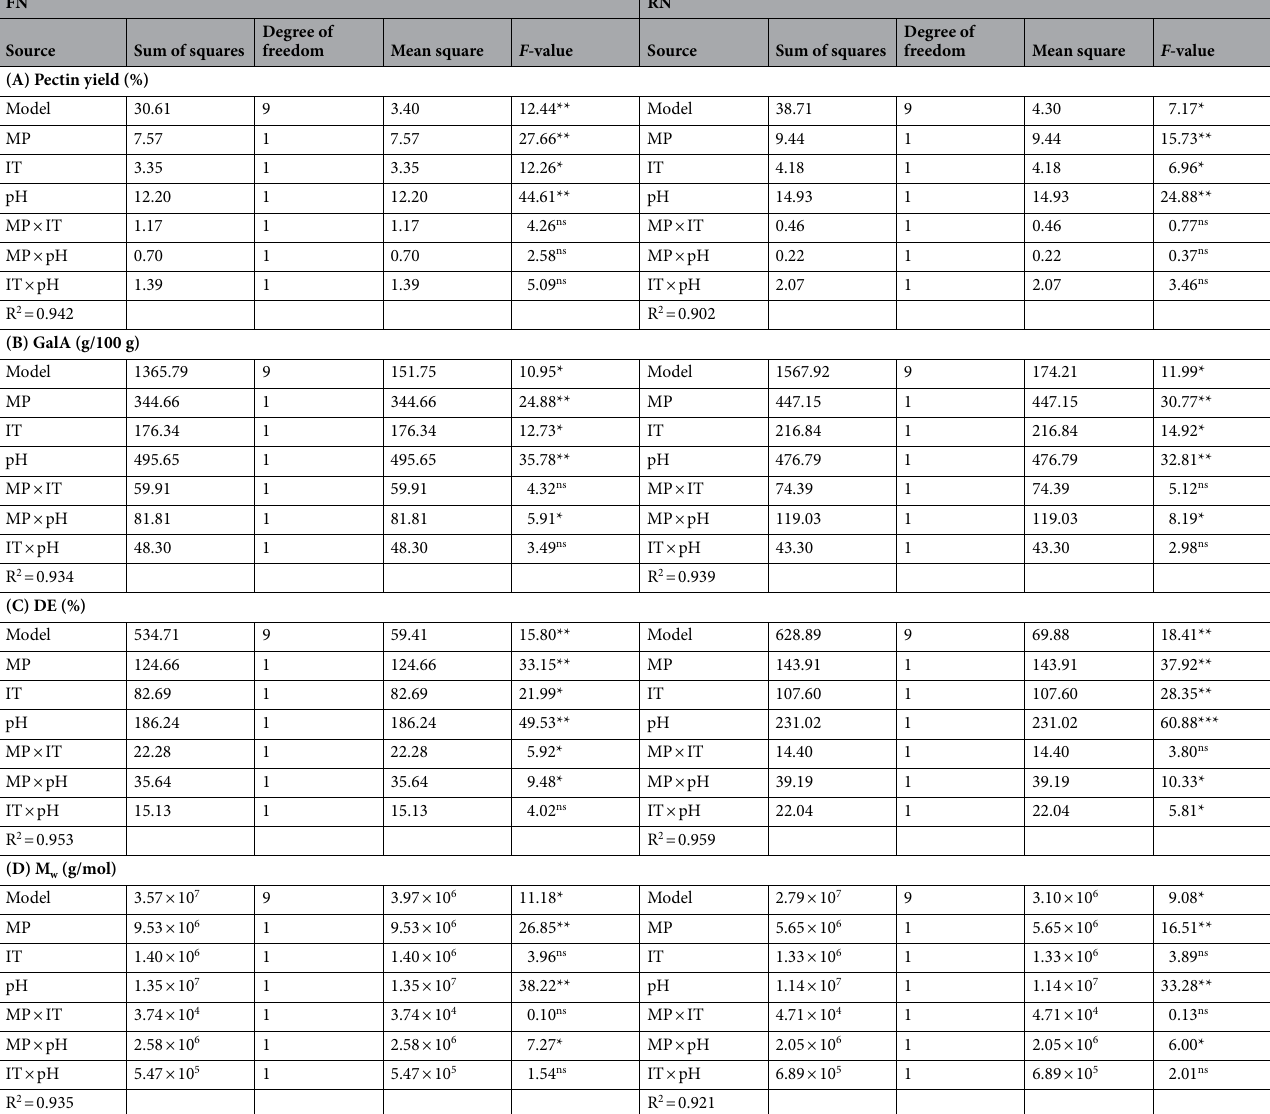
Table 3. Analysis of variance (ANOVA) of constructed quadratic model. ns, p > 0.05; * p < 0.01; ** p < 0.001; *** p < 0.0001; FN, Fetească Neagră; RN, Rară Neagră; GalA, galacturonic acid content; DE, degree